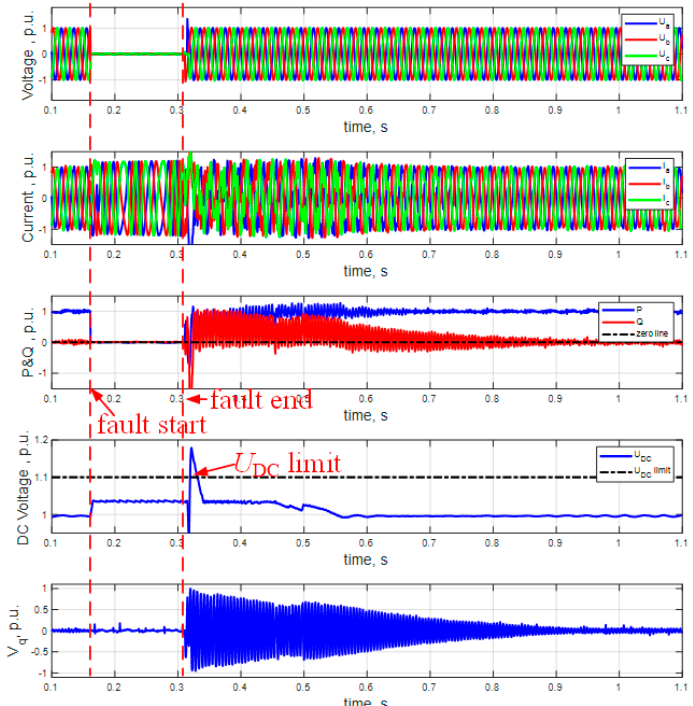
Figure 12. With reactive current injection, the SEP was located in area II during the fault. Then, the system was stable after oscillation. The active power flow temporarily reversed after the fault (P curve is below the black dashed line), resulting in the DC voltage temporarily exceeding the upper limit (black dashed line).